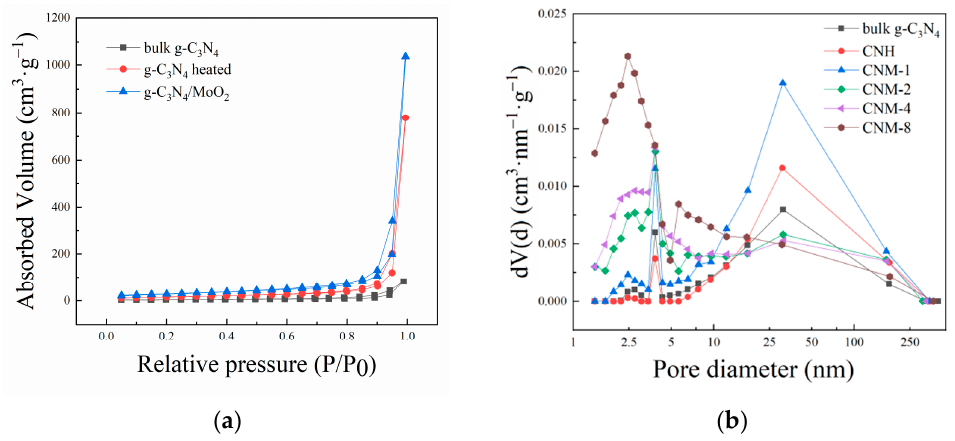
Figure 4. ( a ) N 2 adsorption-desorption isotherm and ( b ) pore diameter distribution of the prepared samples. Table 2. S BET , pore volume, and pore diameter of the prepared